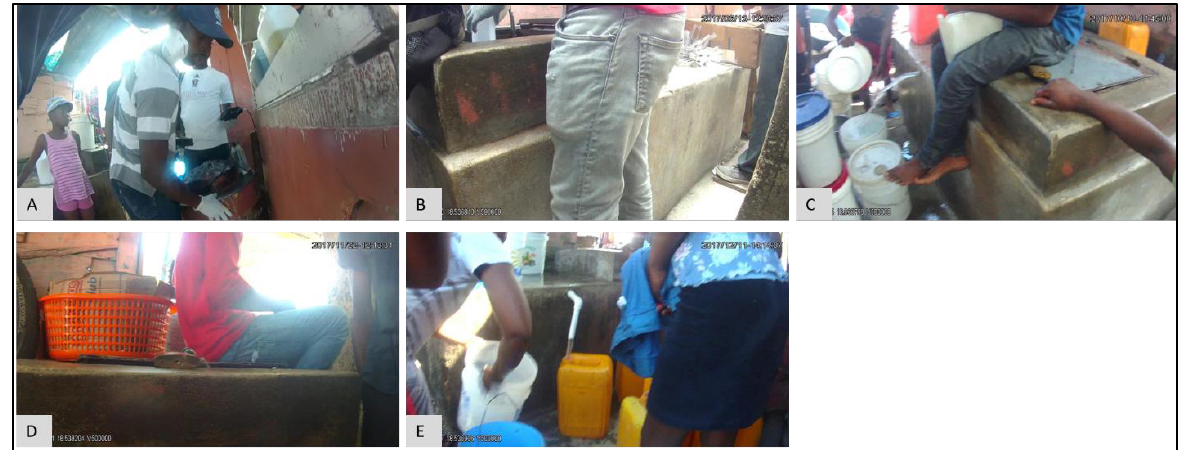
Figure 17. SV images for water point P1 for: ( A ) May, ( B ) June, ( C ) October, ( D ) November, and ( E ) December 2017.